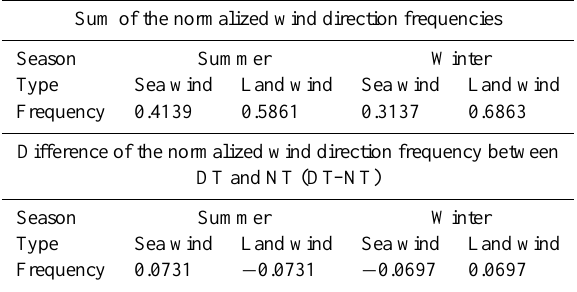
Table 5. Sum of the normalized wind direction frequencies between summer and